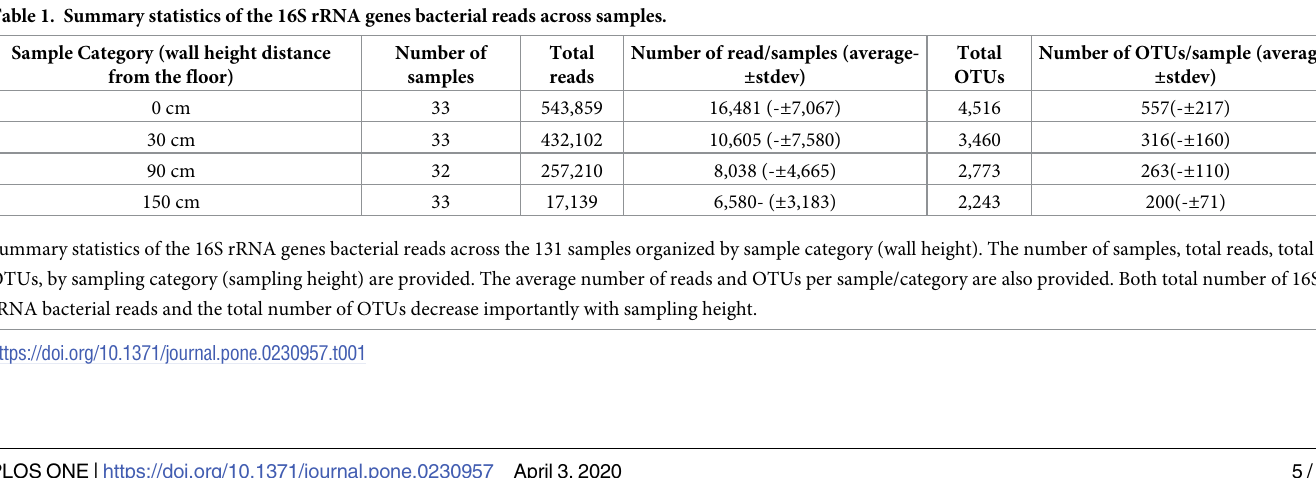
Table 1. Summary statistics of the 16S rRNA genes bacterial reads across samples. Sample Category (wall height distance from the floor)